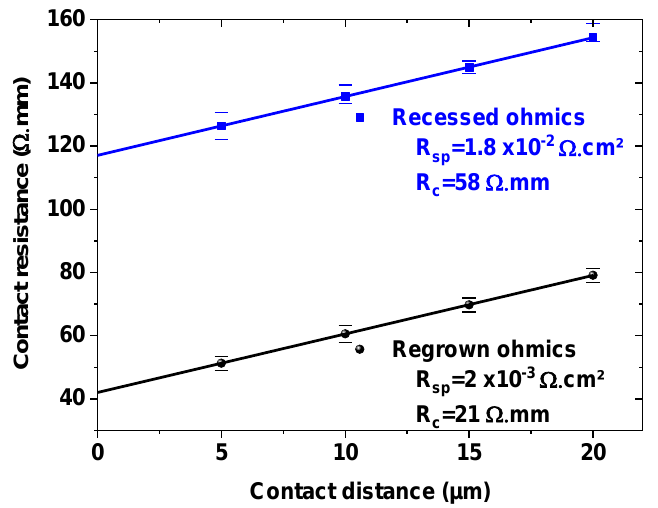
Figure 3. Contact distance dependence on transmission line method (TLM) resistance for re- cessed/annealed and regrown n+ GaN ohmic contacts on the fabricated AlGaN channel HEMTs.